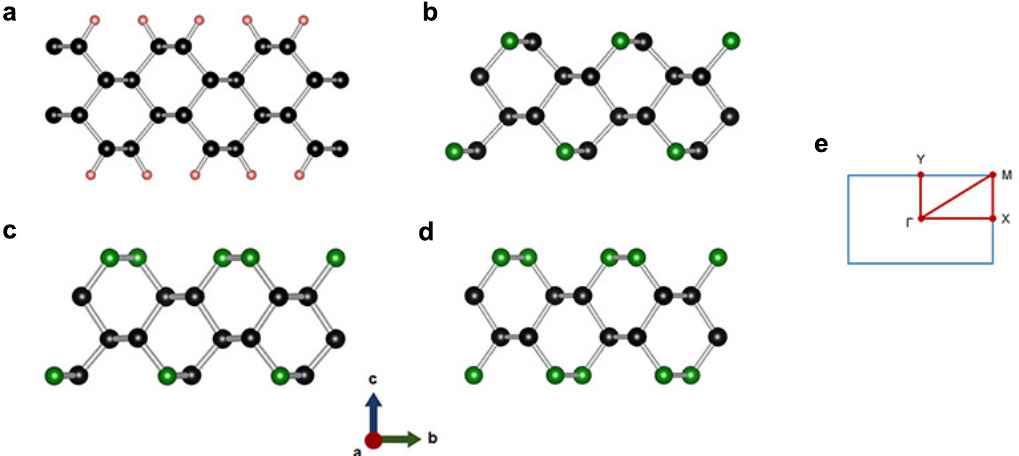
Figure 1. Structures of ( a ) C 8 H 4 , ( b ) C 6 N 2 , ( c ) C 5 N 3 , and ( d ) C 4 N 4 where the black, red and green balls are C, H, and N atoms, respectively. The θ indicates to the angle measured between surficial and inner atoms. ( e ) Paths between high symmetry points in the Brillouin